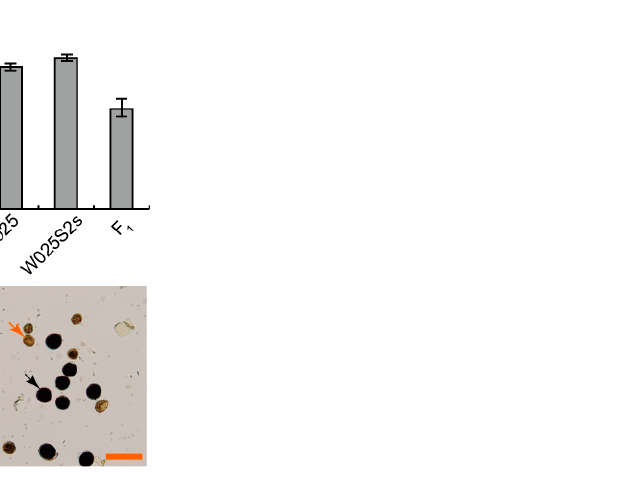
Figure 1. The effect of S 2 . ( A ) Seed fertility observed in W025, W025S2s and their F1 hybrids. Mean ± S.D. are shown. ( B ) Pollen fertility observed in W025, W025S2s and their F1 hybrids. Mean ± S.D. are shown. ( C ) Panicles of W025 ( left ), W025S2s ( middle ) and their F1 hybrid ( right ). Bar = 2 cm. ( D ) Pollen grains of F1 hybrid. Black and orange arrows indicate fertile and sterile pollen grains, respectively. Bar = 100 µ m.